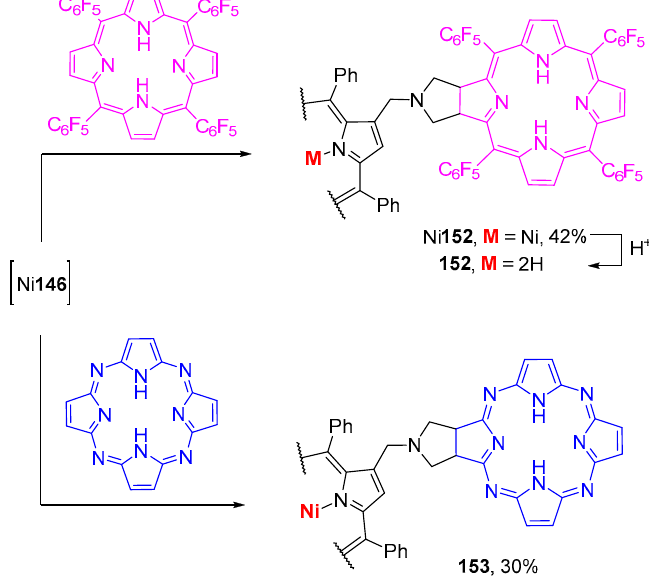
Figure 17. Fullerene-phthalocyanine-porphyrin triads and pentads [161]. 7. Final Remarks As shown in this review, porphyrin macrocycles containing simple substituents like the formyl one at pyrrolic positions provide versatile building blocks for the preparation of new significant derivatives through easy synthetic strategies. Examples of the latter are the reactions with methylene active compounds, amines and other nitrogen derivatives and with Wittig reagents. Further manipulation of some of the obtained derivatives, namely those bearing chalcone, imine/amine and vinyl units allows thee expansion to a plethora of new compounds. Other transformations like the 1,5-electrocyclic ring closure of porphyrinic azomethine ylides can give rise to pyrrolo[3,4- b ]porphyrins and these can afford efficiently 1,3-dioxopyrrolo[3,4- b ]porphyrins and anhydrides. The